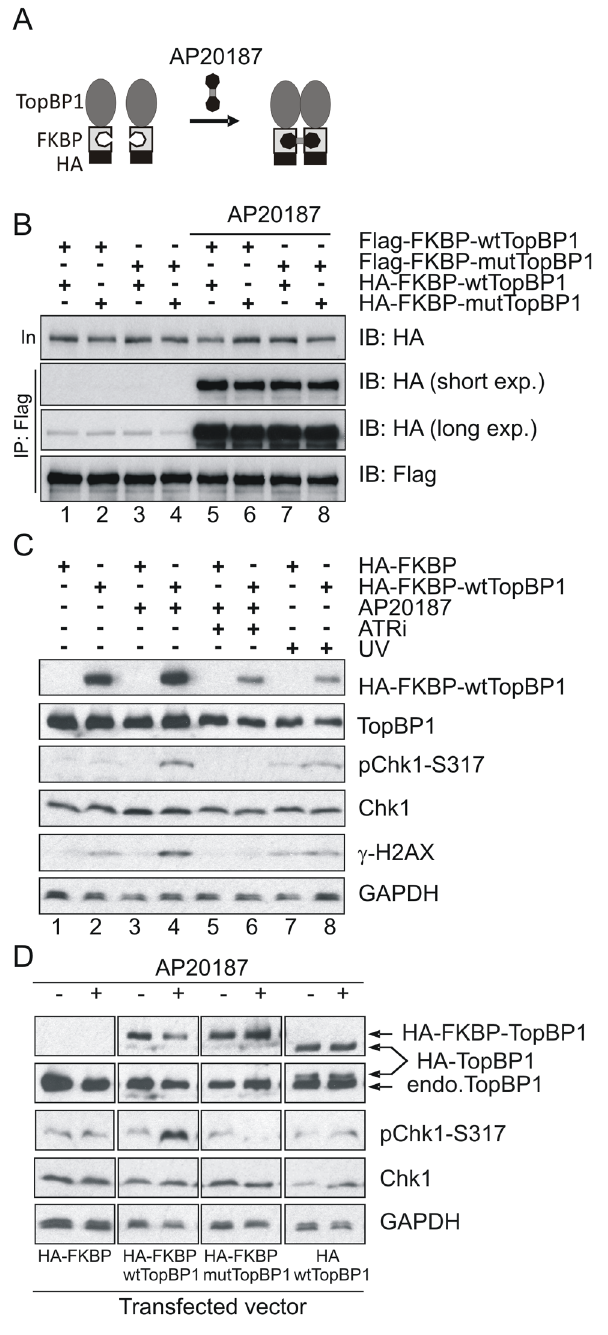
Figure 6. Inducible dimerization of TopBP1 activates ATR-Chk1. ( A ) Schematic showing the inducible dimerization. Addition of AP20187 induces dimerization (interaction) of FKBP-containing proteins. ( B ) Immunoprecipitation (IP) coupled immunoblot (IB) analysis of HEK293T cells that were transfected with the indicated vectors (Flag-tagged and HA-tagged). Cells were treated with 100 nm of AP20187 for 1 hr and analyzed by IP-IB using indicated antibodies. ( C ) IP-IB analysis of HEK293T cells after transfection with empty vector (HA-FKBP) or wild type TopBP1 (HA-FKBP-wtTopBP1). Cells at 40 hr after transfection were incubated with 100 nm of AP20187 for 1 hr without or with 1.6 mM of ATR inhibitor (ATRi) or were treated with 100 J/m-2 UV. Immunoblot analysis was performed 1 hr after respective treatment. ( D ) IP-IB analysis of HEK293T cells after transfection with empty vector (HA-FKBP), or FKBP-fused wild type TopBP1 (HA-FKBP-wtTopBP1), or FKBP-fused AAD mutant TopBP1 (HA-FKBP-mtTopBP1), or wild type TopBP1 without FKBP